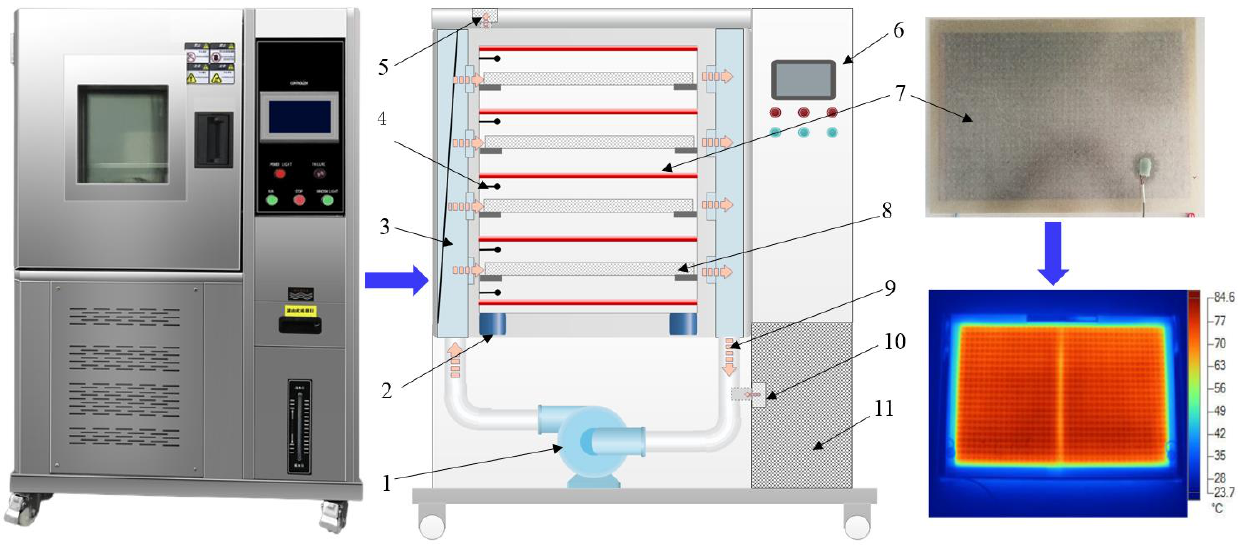
Figure 3. Schematic diagram and photos of HAIR drying equipment. (1) centrifugal fan; (2) load cell; (3) air distribution chamber; (4) temperature sensor; (5) air outlet; (6) control system; (7) infrared carbon-fiber sheet; (8) tray; (9) air flow; (10) air inlet; (11) air filter.